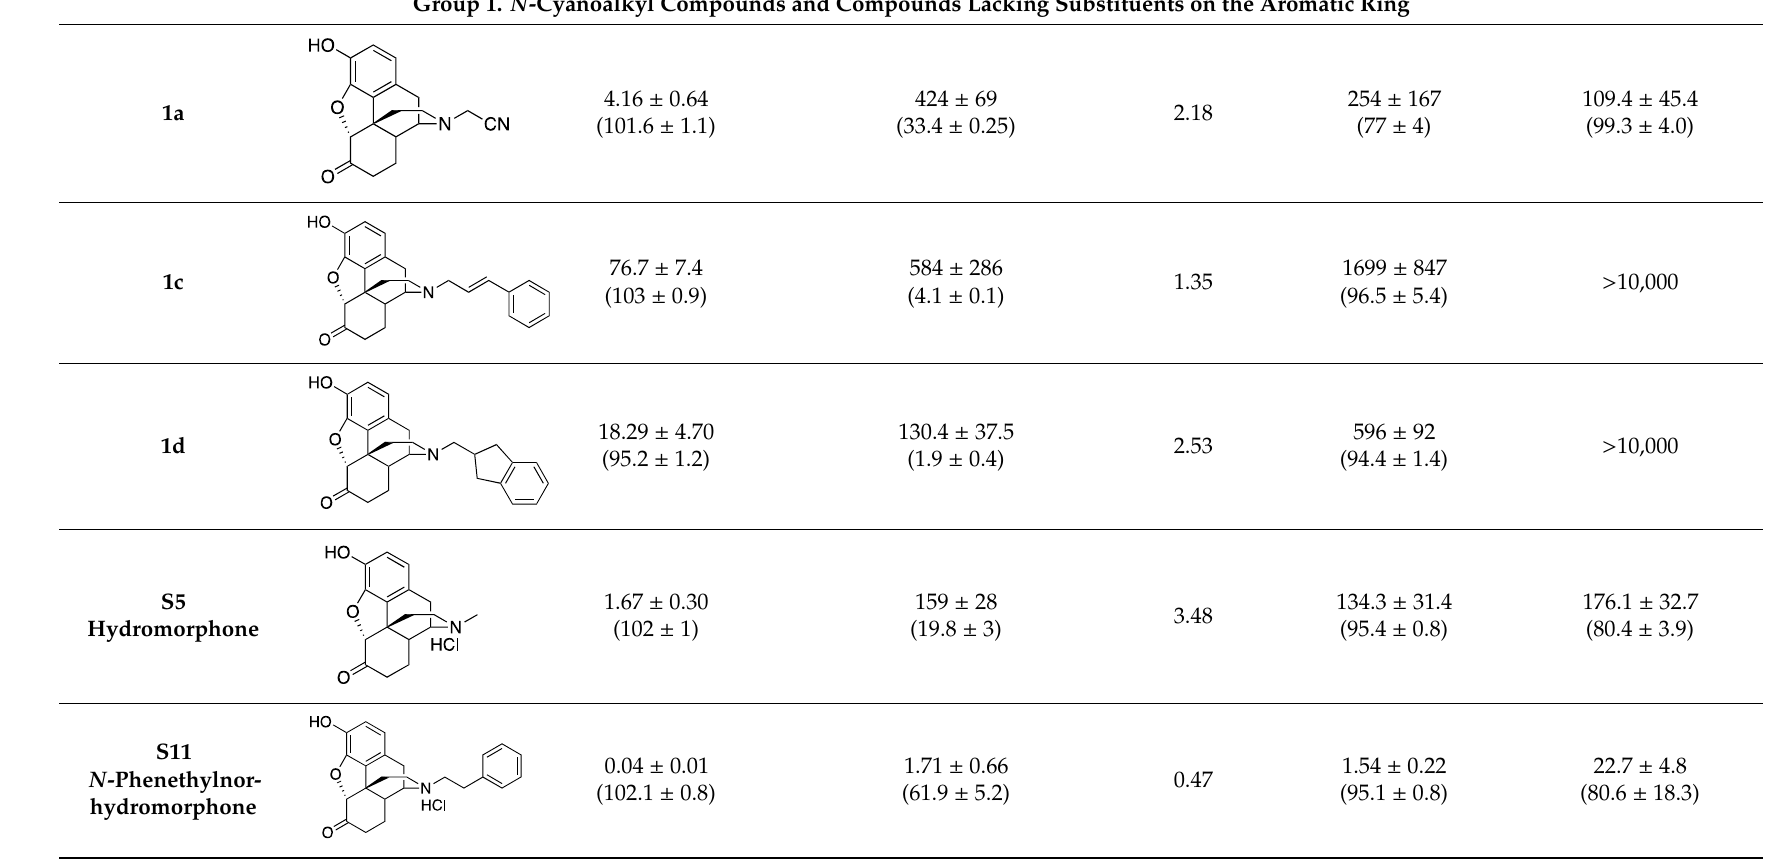
Table 2. Opioid Receptor Activity Measured in the Forskolin-induced cAMP Accumulation Assay a .